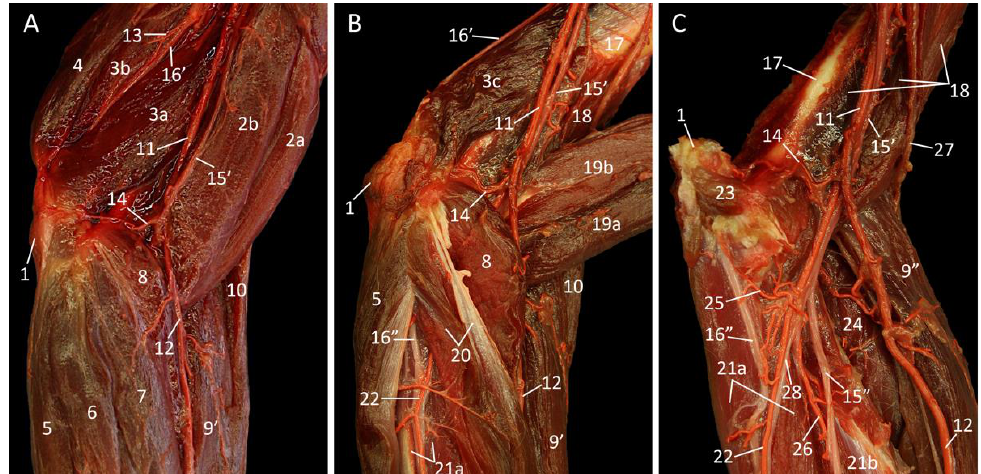
Figure 7. Medial view of the left elbow region; the arterial system is filled with red latex. ( A ): Superficial layer; ( B ): Deeper layer, after partial resection of the m. biceps brachii caput longum and caput breve, and the removal of the m. tensor fasciae antebrachii, the m. palmaris longus, the m. flexor carpi radialis, and the m. triceps brachii caput longum and caput laterale; ( C ): Deepest layer, after the removal of the m. triceps brachii caput laterale, the m. biceps brachii caput longum and caput breve, the m. flexor digitorum superficialis, the m. flexor carpi ulnaris, and the m. pronator teres.